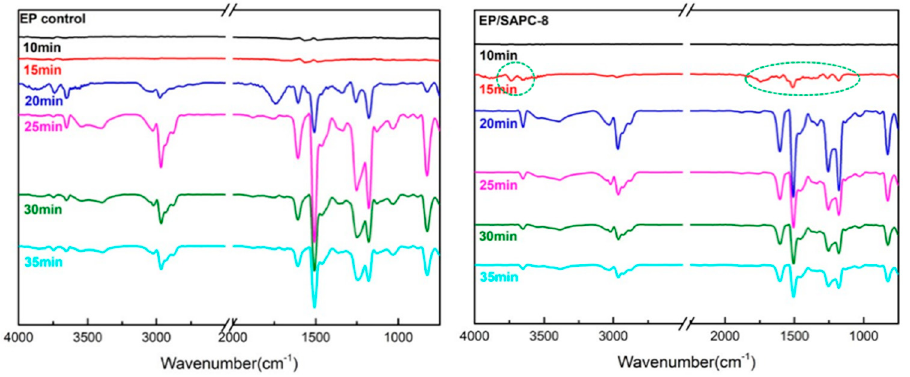
Figure 11. FTIR spectra of the EP control and EP/SAPC-8 at different time periods.